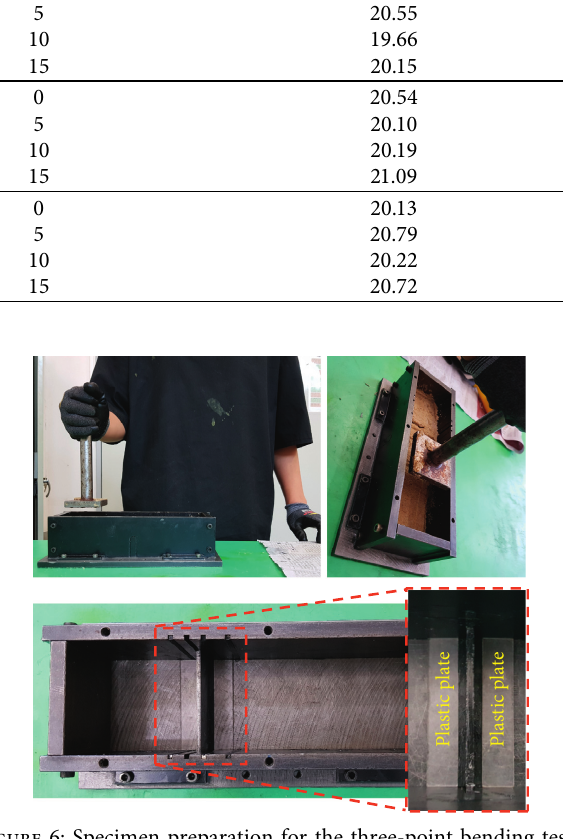
Figure 6: Specimen preparation for the three-point bending tests.